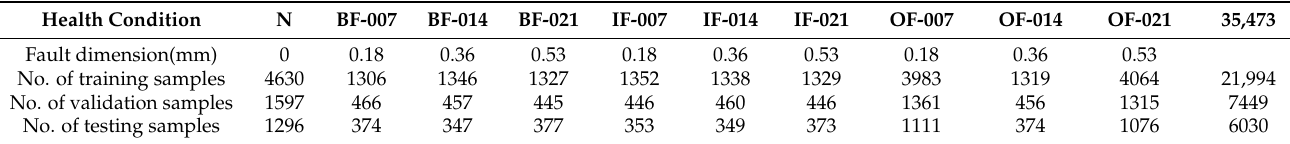
Table 1. Description of the CWRU dataset.